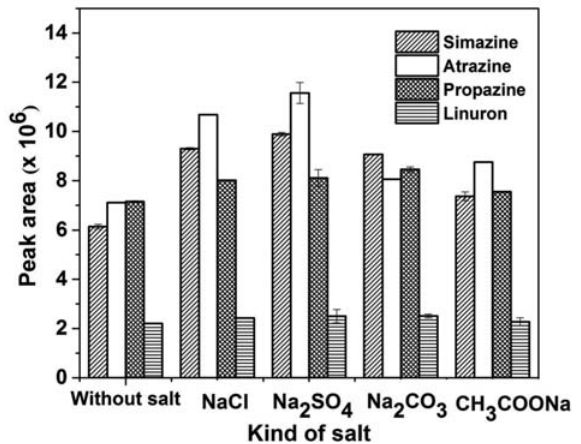
Figure 1c. Effect of volume of 1-octanol on the extraction of selec- ted